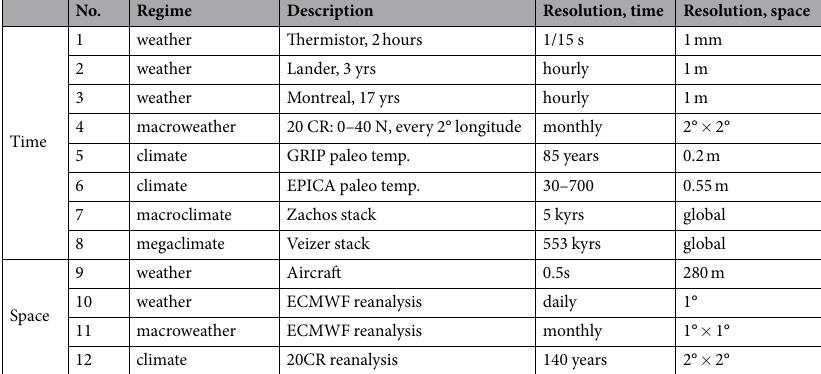
where ϕ is a dimensional quantity driving the process and the equality is understood in a statistical sense, the subscript indicates the resolution in time or in space. H is the fluctuation exponent; it is used in honour of Edwin Hurst who introduced it in hydrology 5 , but it is only the same as Hurst’s exponent for Gaussian processes; the fluctuation exponent is of more general utility. For example, in turbulence in space, if we replace T by a veloc- ity component, and ϕ by the energy flux to the one third power, then H = 1/3 and the equation represents the Kolmogorov law. In general H (and the other scaling exponents) are different in space and in time and different in the horizontal and vertical directions. This is the problem of scaling stratification, scaling anisotropy, “Generalized Scale Invariance” 6 it is out of our present scope; hence to lighten the notation we drop the t , x indices. In the basic picture, ϕ is a Fourier space flux, in this example, the energy per time passing from small to large wavenumbers (large to small scales). The normalized spikes Δ Δ T T / can thus be interpreted as an estimate of the nondimensional, normalized driving flux: